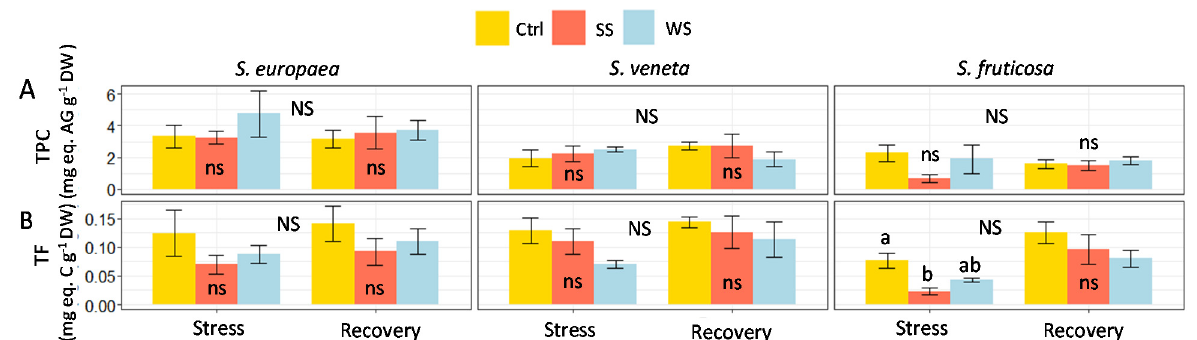
Figure 7. Effect of 30 days of stress treatments (Stress) followed by watering with non-saline water for 15 days (Recovery) on shoot concentration of ( A ) total phenolic compounds (TPC) and ( B ) total flavonoids (TF) in the three halophytes. Ctrl, control; SS, salt stress (watering with 700 mM NaCl); WS, water stress (complete withholding of irrigation). For each species and sampling (Stress or Recovery), different lowercase letters over the bars indicate significant differences between treatments (Ctrl, SS, and WS), at p ≤ 0.05; ns: non-significant. Different uppercase letters indicate significant differences between the two samplings (Stress and Recovery) for each species and treatment, at p ≤ 0.05. NS: non-significant. Vertical bars indicate standard error ( n = 4).